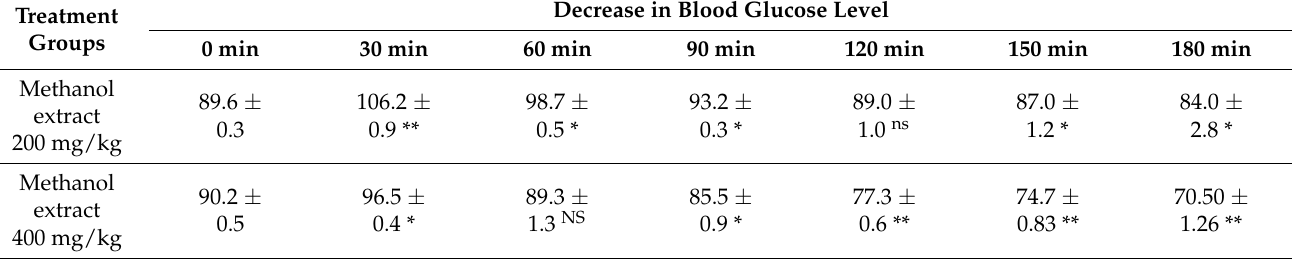
Table 5. Effect of B. calliobotrys on oral glucose tolerance